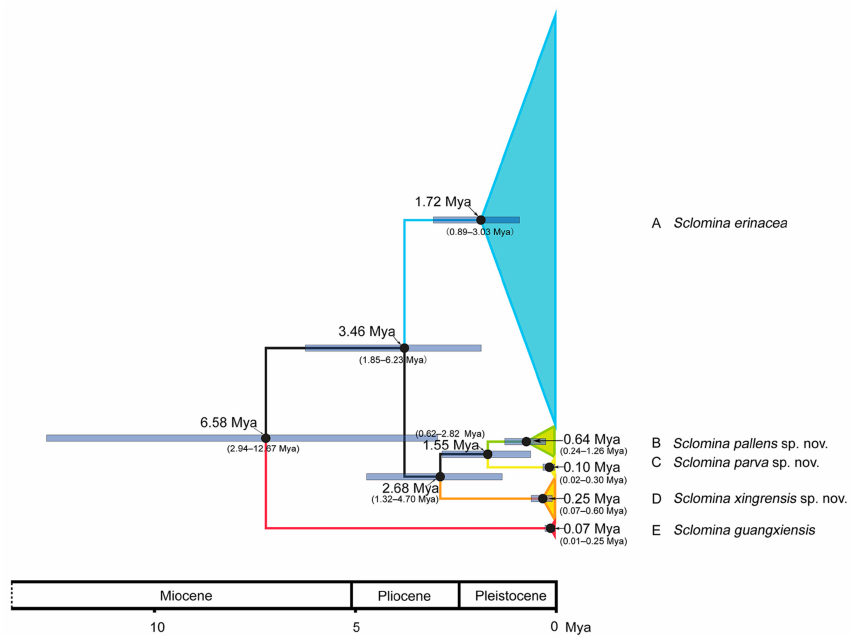
Figure 4. Divergence time tree based on COI data. The clades/species identified in this study are indicated in using the same colors as in Figure 1. The 95% highest posterior density (HPD) intervals are represented by pale blue bars. The x -axis depicts the corresponding geological periods. Mya: million years